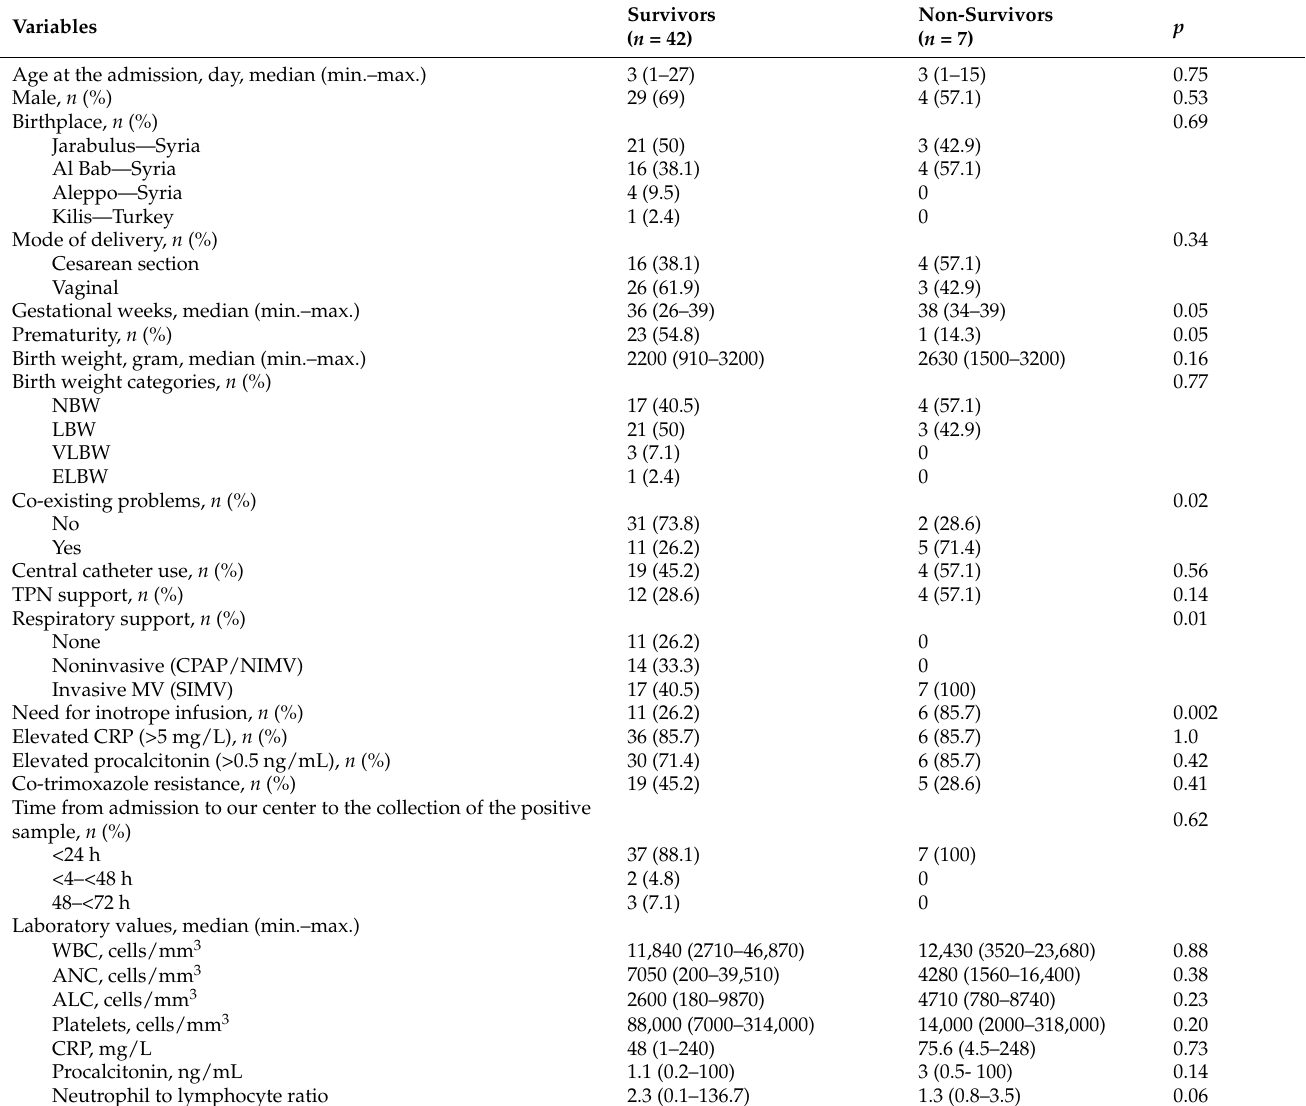
Table 4. Comparison of the variables between survivor and non-survivor neonates with Burkholderia cepacia complex